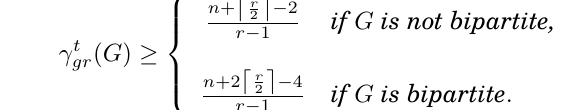
Figure 2: O 1 applied to P 5